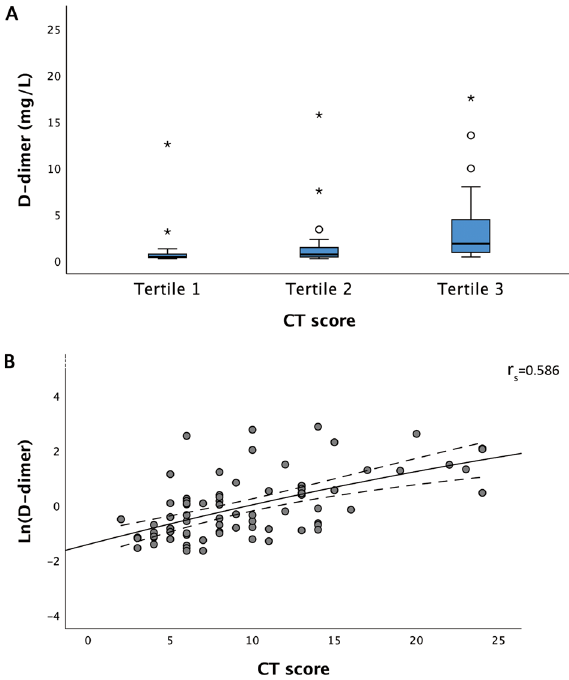
Figure 1. ( A ) The boxplot showing a significant difference in D-dimer levels across CT score tertiles (P < 0.001). ( B ) The scatterplot was showing that the natural logarithm of the D-dimer level was significantly associated with CT score (r s = 0.586, P <